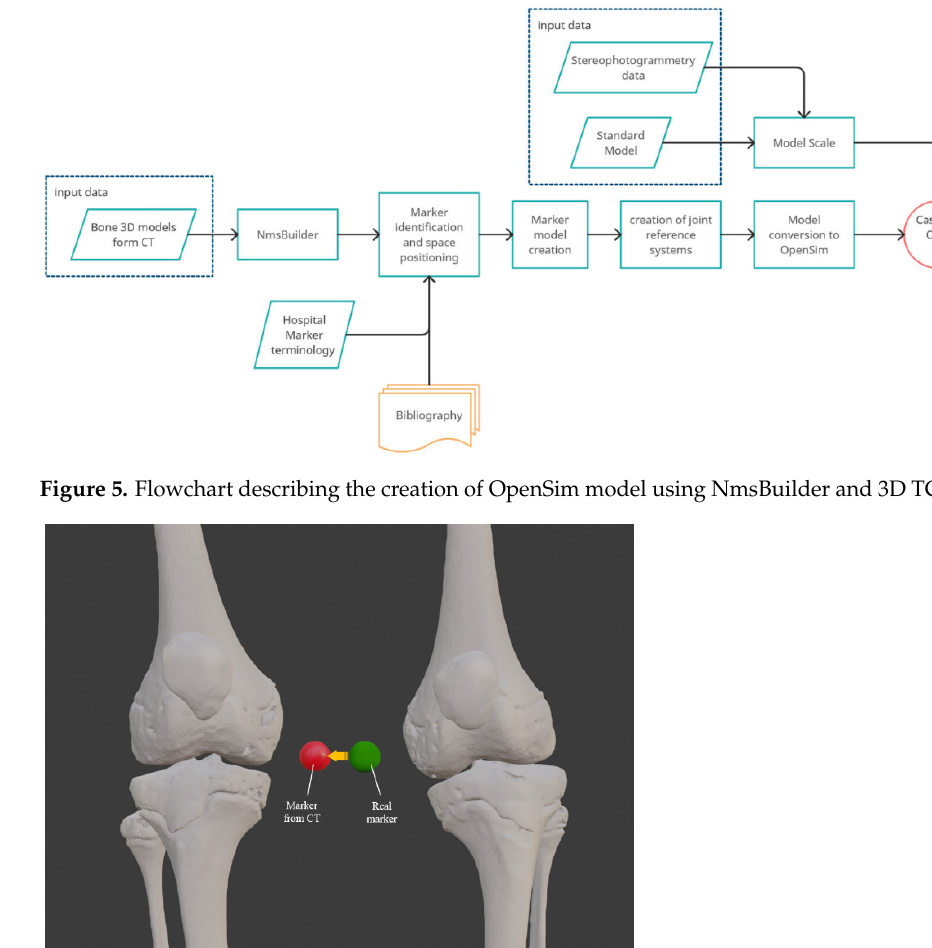
Figure 6. On the right the marker from the associated model, on the left the marker from CT not yet associated.